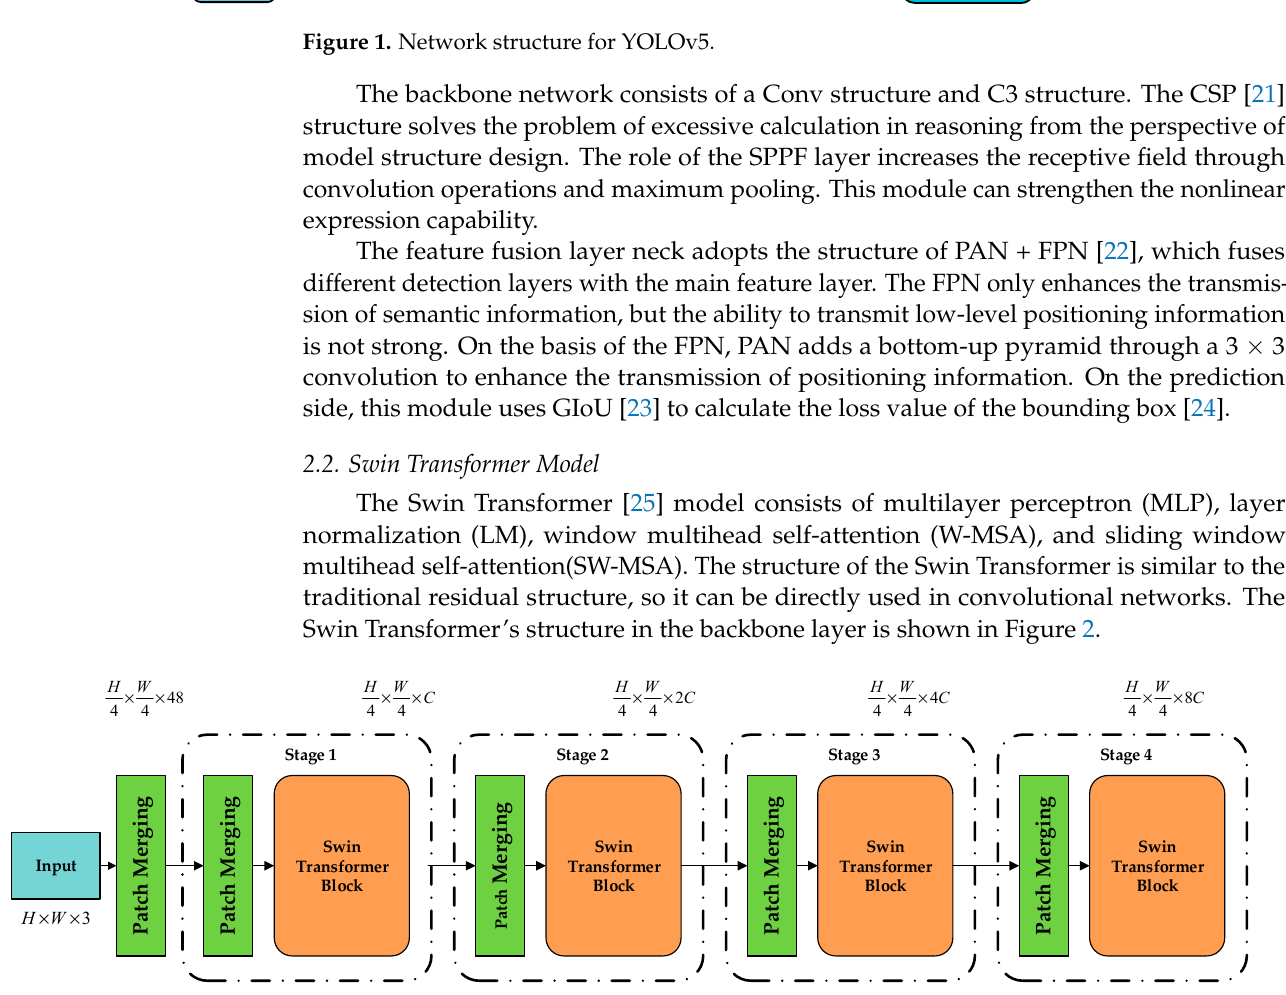
Figure 2. Swin Transformer network structure.